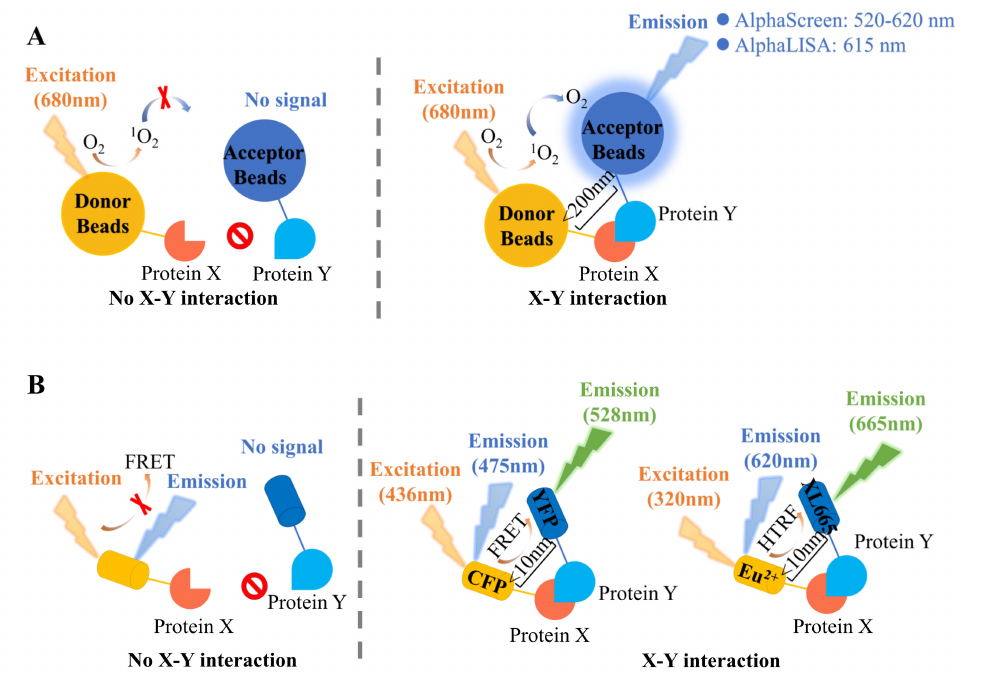
Figure 3. Illustration of representative proximity–based methods. ( A ) Principles of alpha technology. Proteins X and Y are immobilized on donor and acceptor beads, respectively. The photosensitizers in the donor bead convert oxygen (O 2 ) into singlet oxygen ( 1 O 2 ) when it is excited by light at 680 nm. If there is no X–Y interaction (distance between the donor bead and the acceptor bead is greater than 200 nm), the singlet oxygen will fall back to ground state, without any light signal generation. If an X–Y interaction occurs, singlet oxygen initiates a cascade of energy transfer steps in the acceptor bead, resulting in the generation of light emission at 520–620 nm (in AlphaScreen) or 615 nm (in AlphaLisa). ( B ) Principles of Förster resonance energy transfer (FRET). Proteins X and Y are fused with donor and acceptor fluorophores, respectively. In the absence of an X–Y interaction (distance between the donor and the acceptor is greater than 10 nm), donor fluorophore excitation results in light emission from the donor alone. When an X–Y interaction occurs, the donor and acceptor fluorophores are brought into proximity, resulting in energy transfer from the donor to acceptor and acceptor emission. In FRET, the donor and acceptor fluorophores are CFP and YFP, respectively, and the detectable emission light is at 528 nm. In TR-FRET and HTRF, the donor fluorophores are terbium and europium cryptates, respectively. Both acceptors use an XL665 donor fluorophore to generate emission light at 665